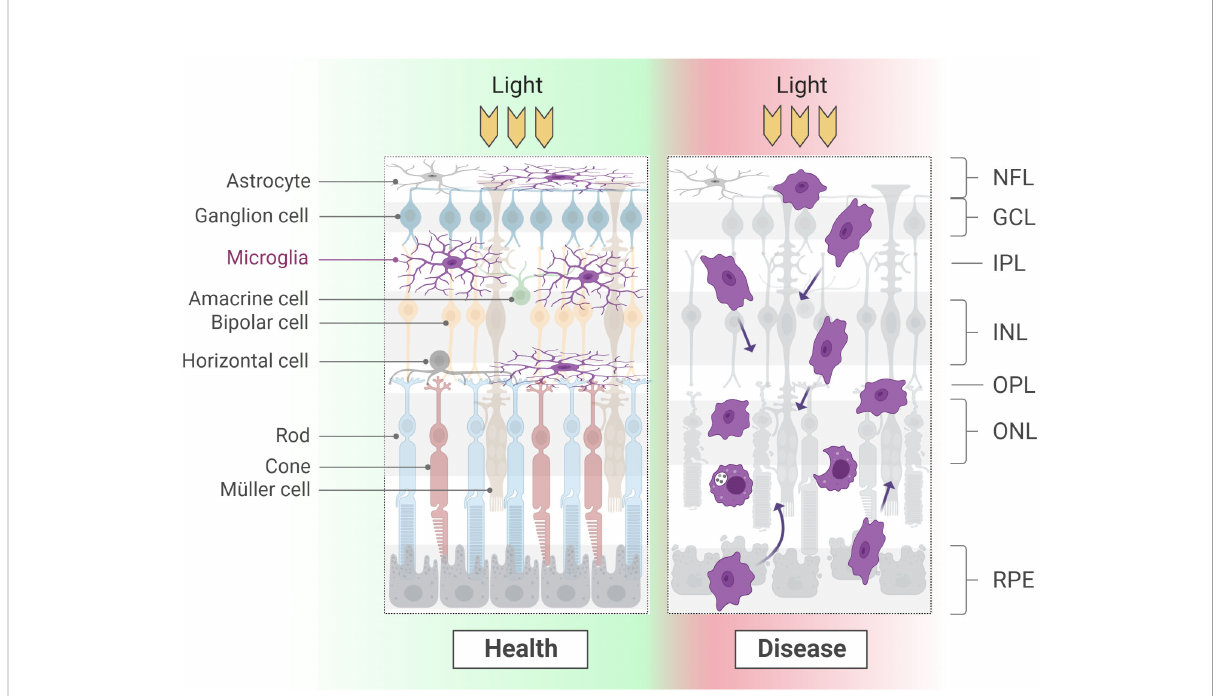
FIGURE 2 Microglial morphology varies considerably according to the developmental and physio-pathological state of the tissue. At adult stages, a long and thin arborization confers microglia the ability to scan large areas of the surrounding environment. When a degenerative process starts, microglia retract the branches and display high motility and phagocyting activity. Of note, while in health microglia occupy the synaptic layers and line ganglion cells fi bers, during degeneration these boundaries are lost. NFL, nerve fi ber layer; GCL, ganglion cell layer; IPL: inner plexiform layer; INL, inner nuclear layer; OPL, outer plexiform layer; ONL, outer nuclear layer; RPE, retinal pigment